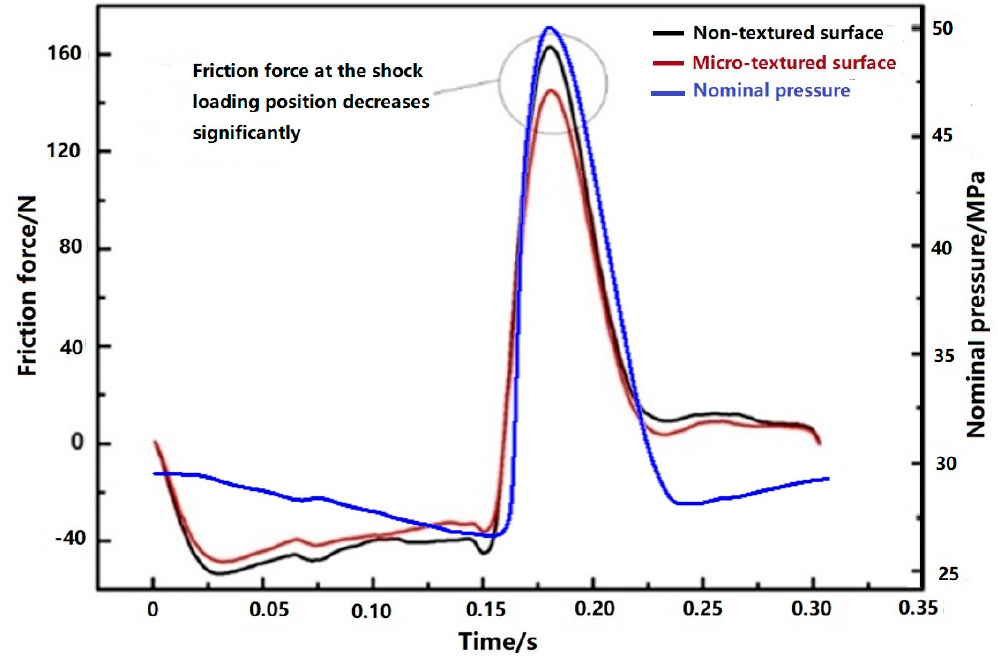
Figure 5. Friction force comparison and nominal pressure variation of a typical reciprocating stroke in the stable wear period.